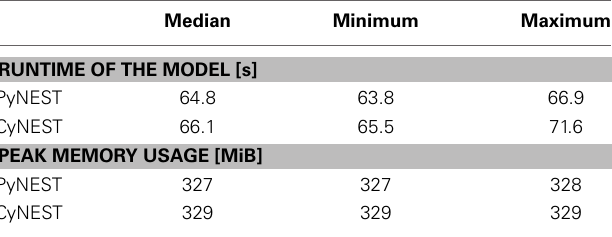
Table 3 | The runtime and memory consumption measurements performed on the untraced version of the simplified Hill-Tononi model using single-threaded simulation on the hardware/software setup described in the main